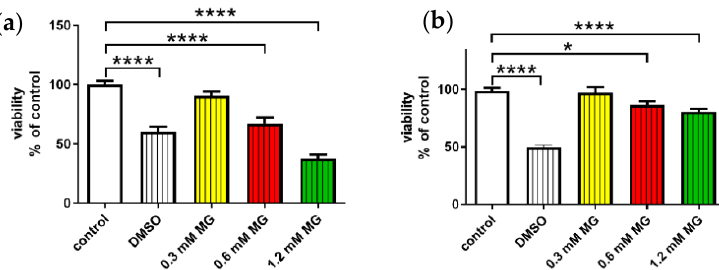
Figure 4. Optimization of methylglyoxal [1] concentration for measuring potential anti-apoptotic properties of PrRP. MG toxicity was measured with an MTT assay: ( a ) in SH-SY5Y cells; ( b ) in rat primary neuronal culture. Data are presented as the means ± SEM as a percentage of control cells treated with vehicle. Statistics: one-way ANOVA followed by the Dunnett post hoc test, * p < 0.5, **** p < 0.0001 ( n = 3, each sample in octuplicates).